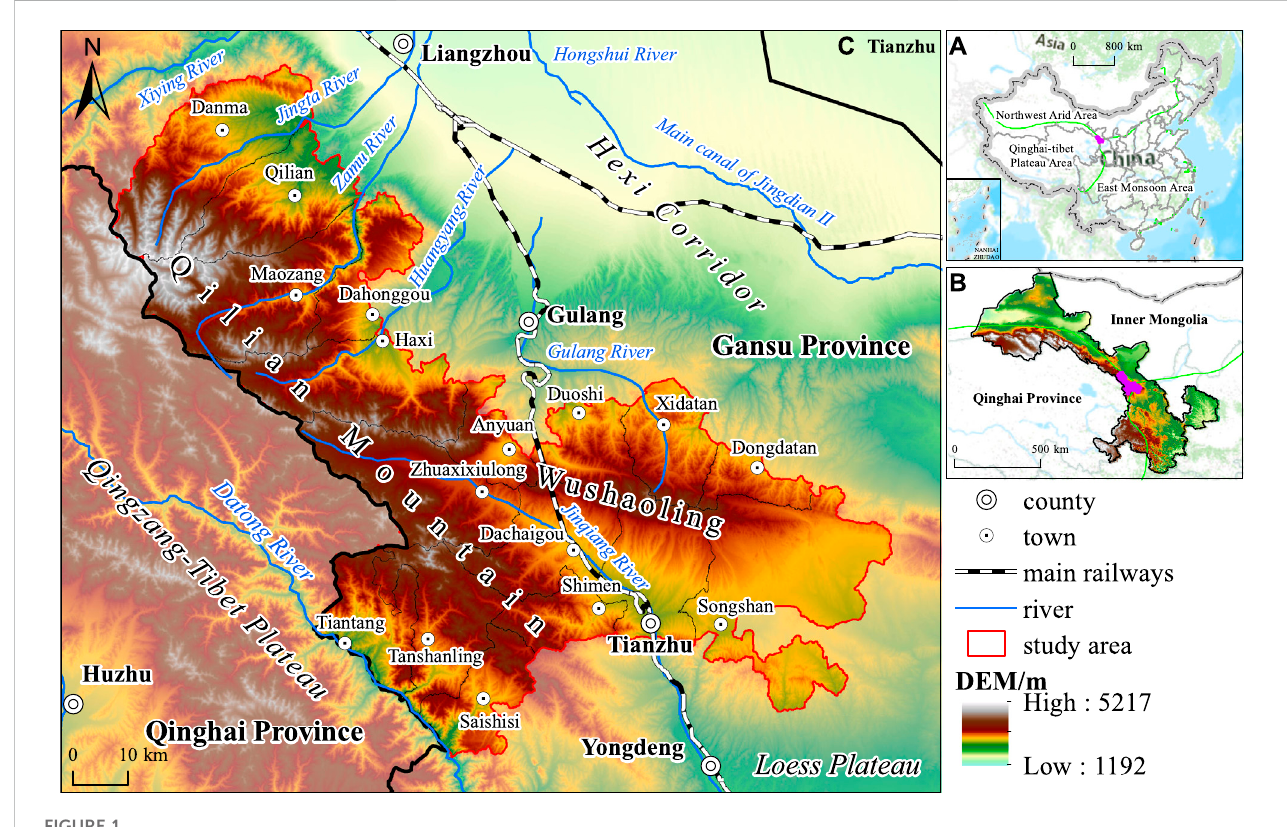
FIGURE 1 Location of the study area.